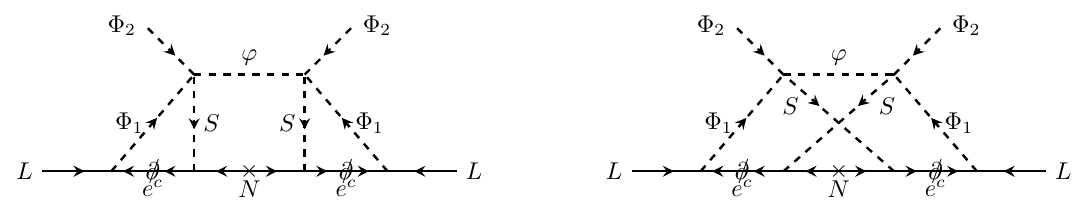
Figure 23 . Neutrino mass diagrams for the AKS model in the gauge